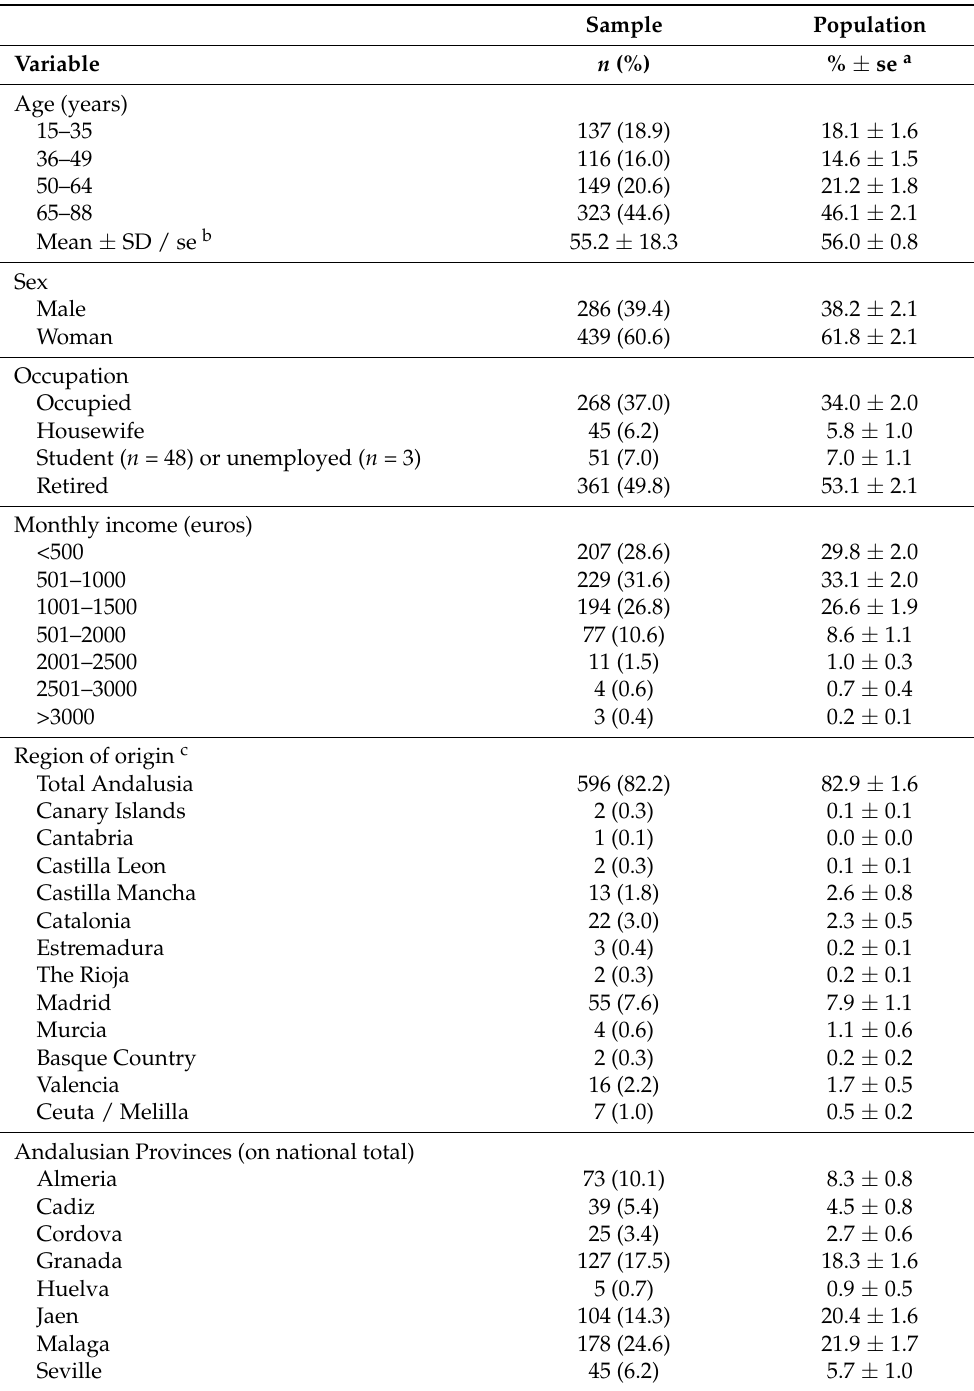
Table 1. Sociodemographic distribution of users ( n =